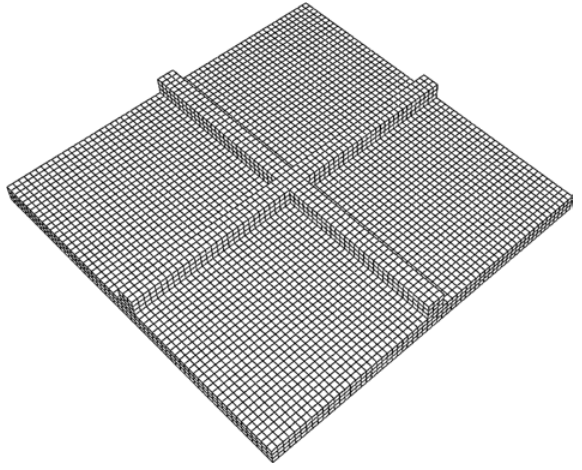
Figure 12: Three-dimensional AGS composite structure finite element model.